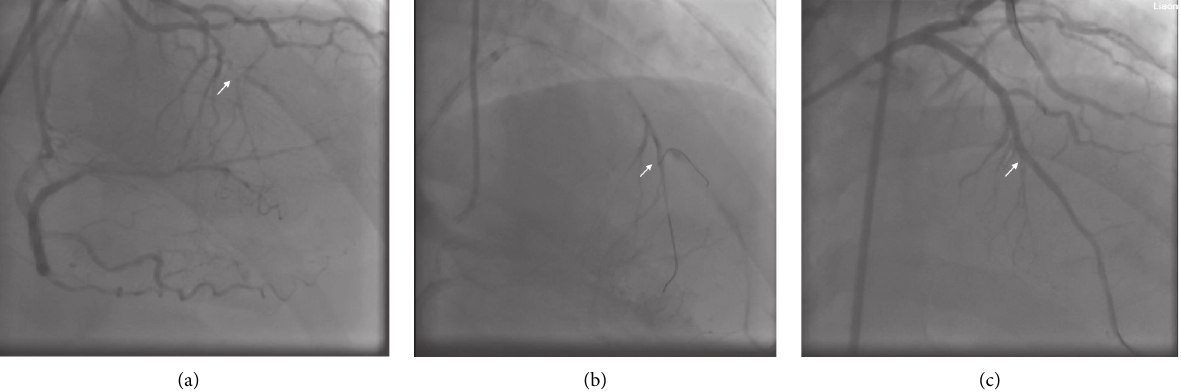
Figure 2: (a) A patient with CTO at the proximal anterior descending branch (LAD), where the distal end of the occluded segment was blunt, and with a relatively large septal branch. The true opening of the main vessel was h-shaped due to the restriction of the plaques. (b) ARW was used to reversely deliver the wire from the septal branch to LAD. (c) The occluded segment was successfully recanalized.